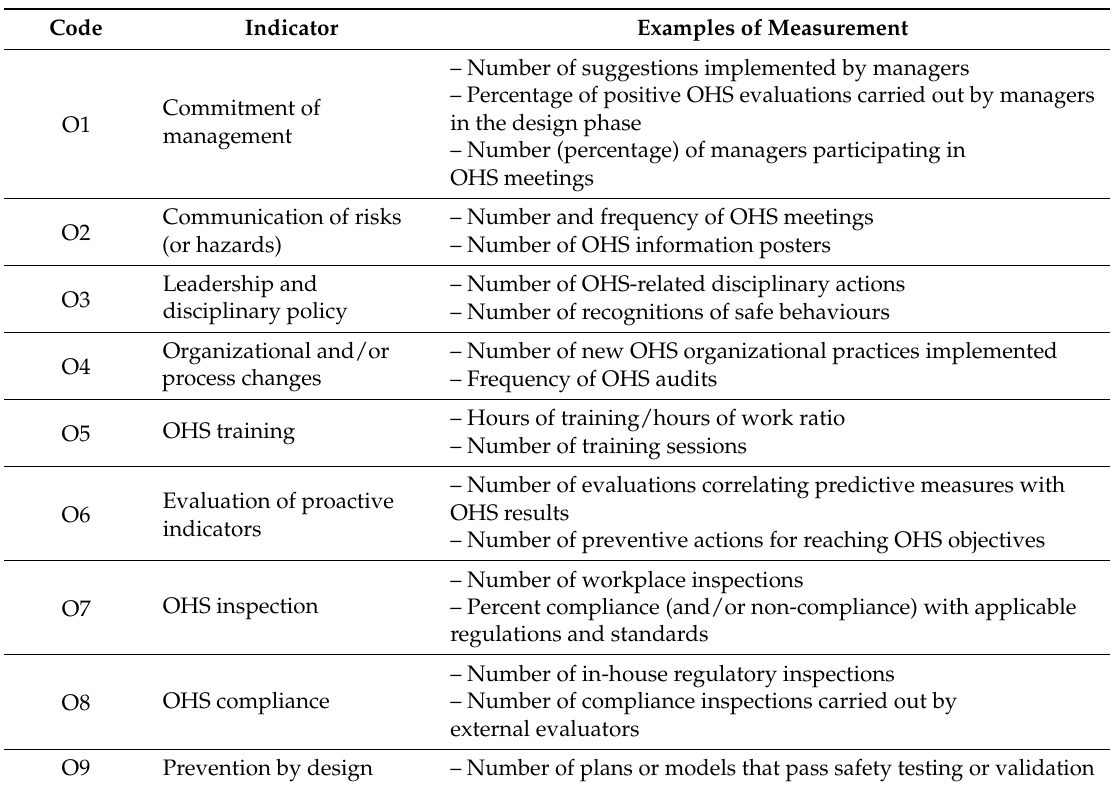
Measurable indicators of risk management maturity based on organization and management-based indicators.